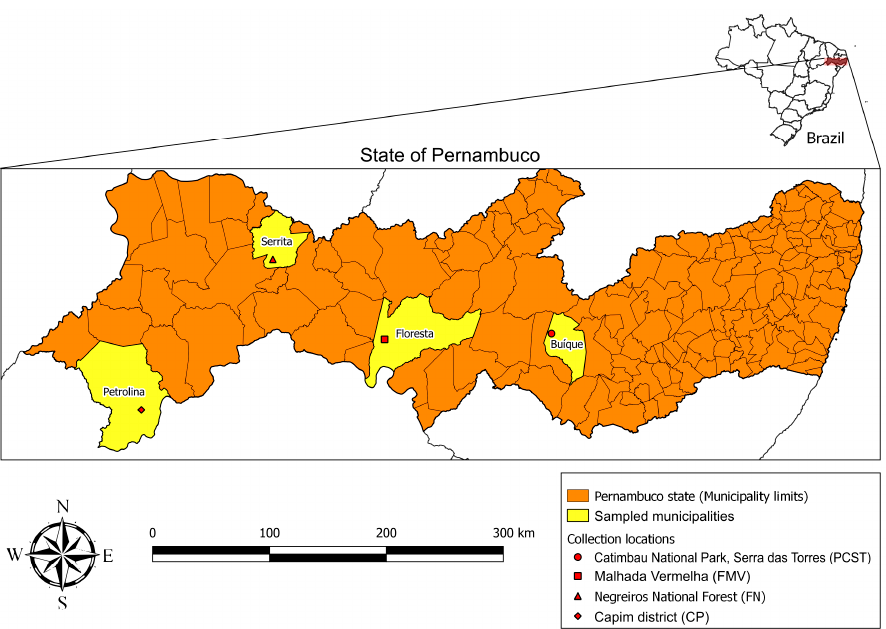
Figure 1. Locations in the state of Pernambuco, northeastern Brazil, where Ornithodoros ticks were collected.